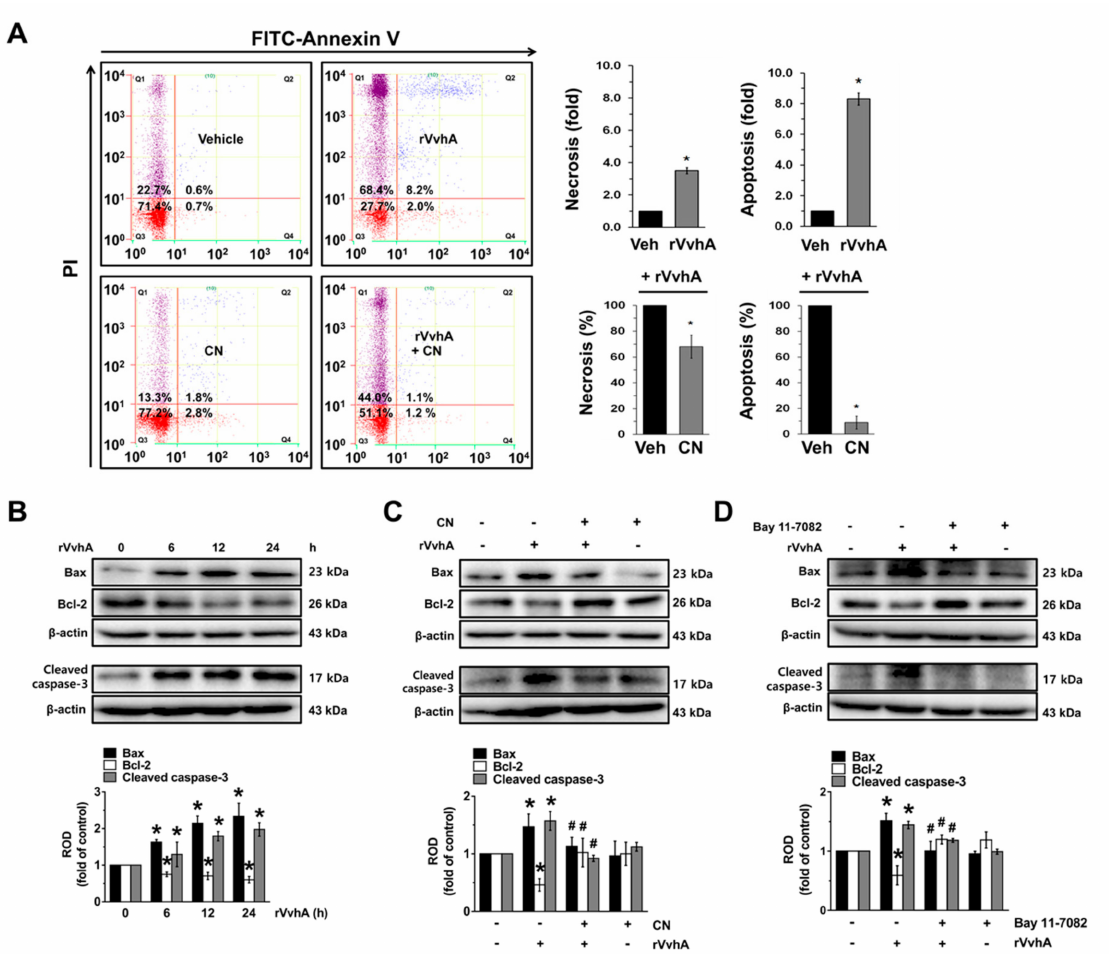
Figure 5. The role of CN on apoptotic cell death induced by rVvhA. ( A ) Cells were incubated with CN for 30 min prior to rVvhA exposure for 24 h. Percentages of total apoptotic cells were measured by using PI / Annexin V staining and flow cytometry. n = 4. * p ≤ 0.01 vs. control. # p ≤ 0.01 vs. rVvhA alone. ( B ) Expression of Bax, Bcl-2, and cleaved caspase-3 in cells exposed to rVvhA are shown. n = 3. * p ≤ 0.01 vs. control. ( C ) The e ff ect of CN on the expression of apoptosis-related protein is shown. n = 3. * p ≤ 0.01 vs. control. # p ≤ 0.01 vs. rVvhA alone. ( D ) Cells were pretreated with Bay 11-7082 prior exposure to rVvhA for 24 h. n = 3. * p ≤ 0.001 vs. control. # p ≤ 0.01 vs. rVvhA alone. Data represent the mean ± S.E. ( B – D ) ROD is the abbreviation for relative optical